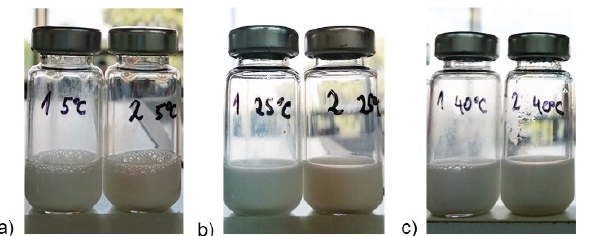
Figure 1. Visual appearance of nanoemulsions prepared with polysorbate 80 without raspberry oil on the left (sample 1—F0 P80 NE, where creaming process is visible on the glass vial wall) and with raspberry oil on the right (samples 2—F1 P80 NE, with improved stability) stored at different temperatures: ( a ) 5 °C, ( b ) 25 °C, and ( c ) 40 °C.